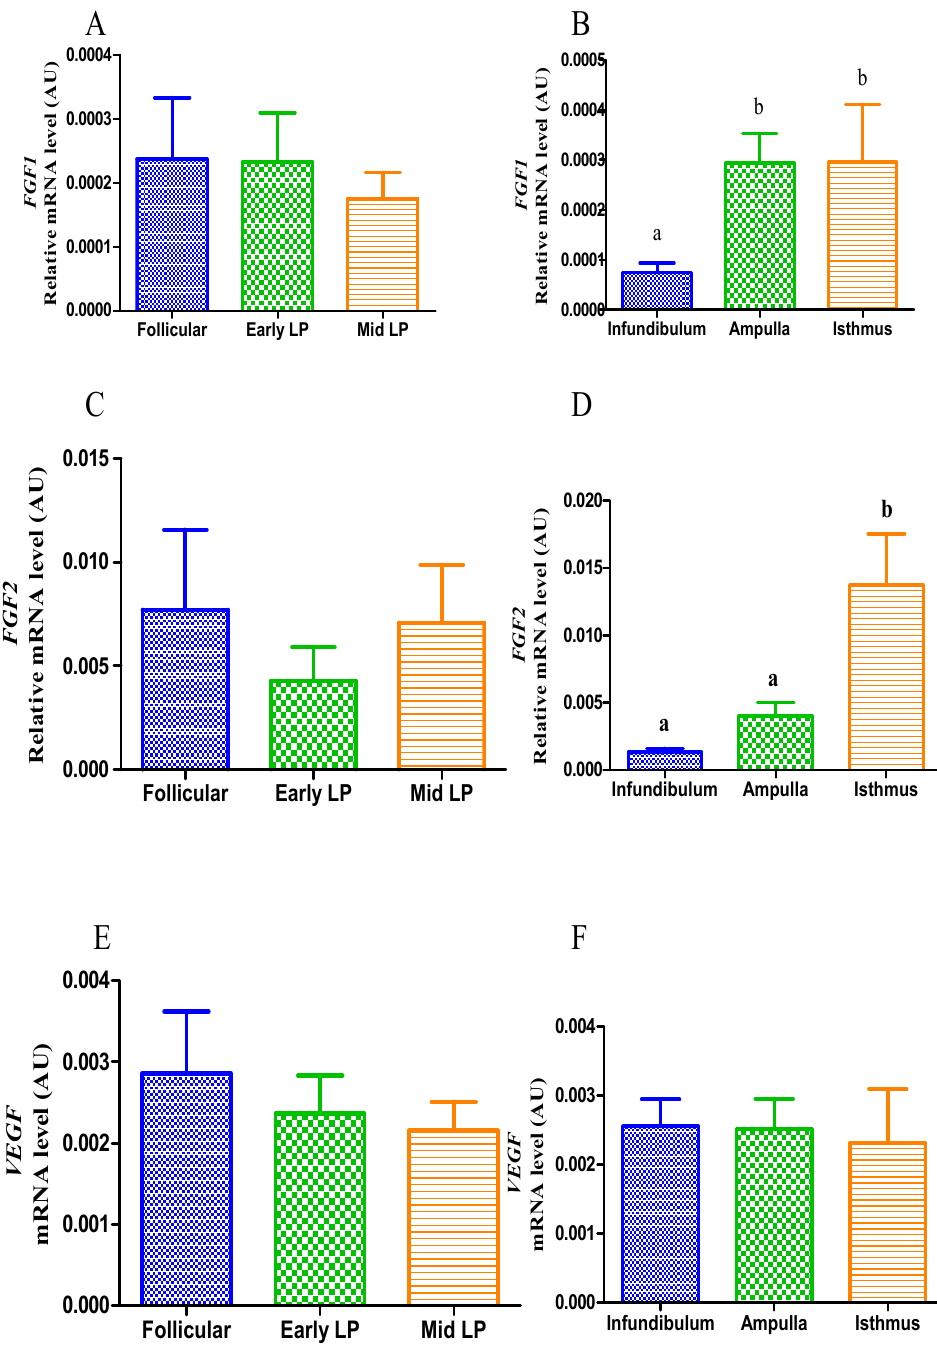
Figure 5. Relative quantification of FGF1 , FGF2 and VEGF transcripts in the equine oviduct ( n = 5 samples for each estrous cycle phase; n = 5 for each portion of oviduct analyzed). Comparison of transcripts between the follicular phase, early-luteal phase (Early LP), and mid-luteal (Mid LP) ( A , C , E ). Comparison of transcripts between oviduct portions (infundibulum, ampulla, isthmus), regardless of the phase of the estrous cycle ( B , D , F ). Bars represent mean ± SEM. AU: arbitrary units. Different letters indicate significant differences ( p <